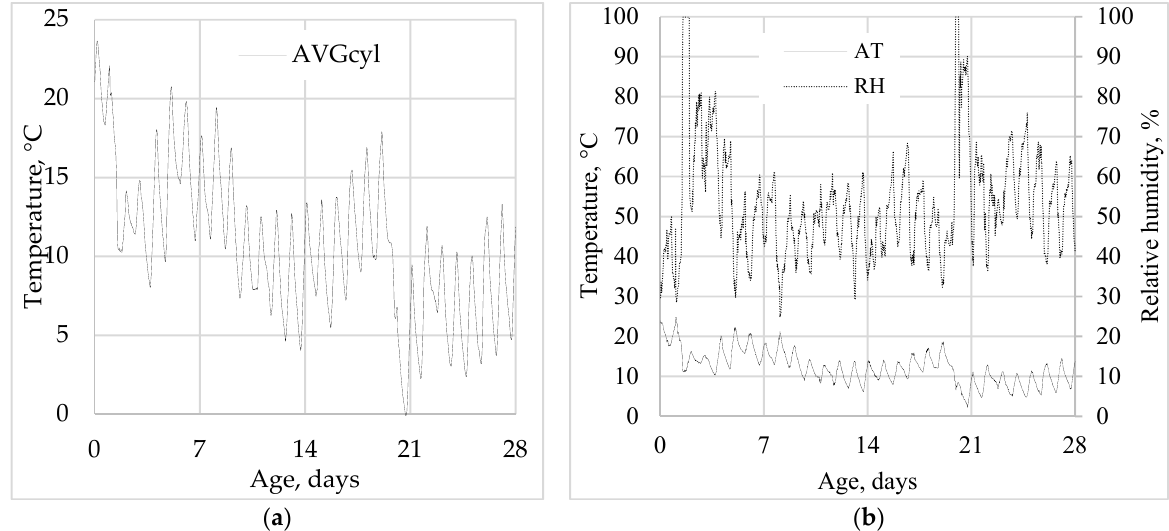
Figure 5. Temperature and humidity monitoring for concrete cylindrical samples over time: ( a ) Internal temperature fluctuation (average value); ( b ) Ambient temperature and ambient relative humidity.